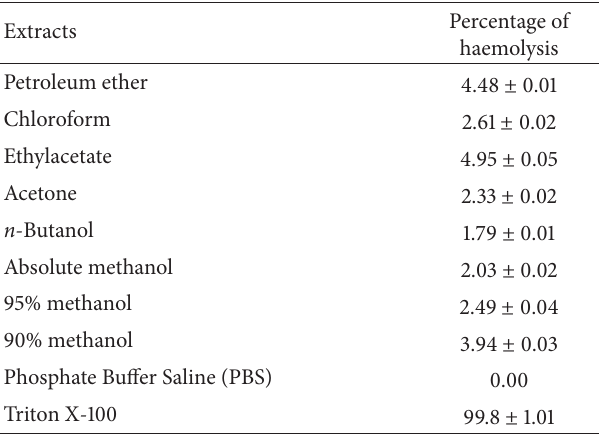
Table 2: Percentage haemolysis caused by C. viminalis leaves differ- ent extracts a